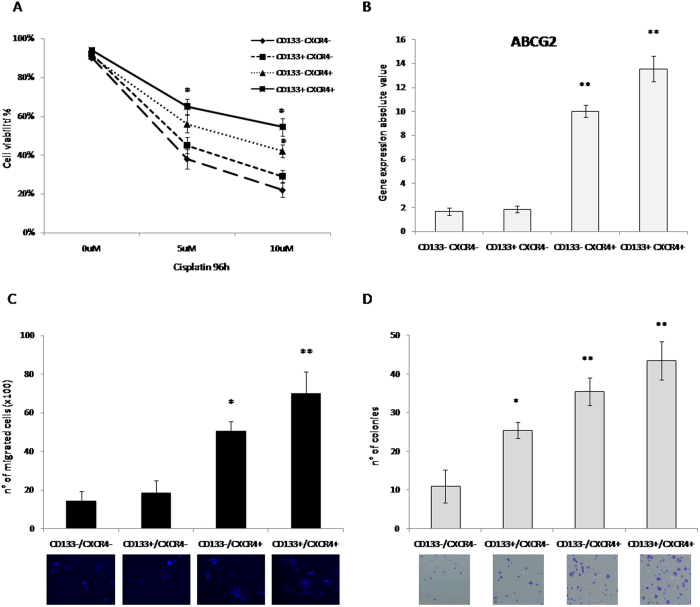
CXCR4+CD133+ ovarian cancer cells possess resistance to chemotherapy, migration and colony forming capabilities. OVCAR-5 sorted cells (A) Cytotoxicity assay in the presence of Cisplatin (0, 5, 10M). (B) QPCR analysis of ABCG2. (C) Migration assay toward CXCL12 and (D) Clonogenic assay. A representative photograph is provided in the lower panel. (*p < 0.05, **p values < 0.001, compared with the CD133-CXCR4- group).